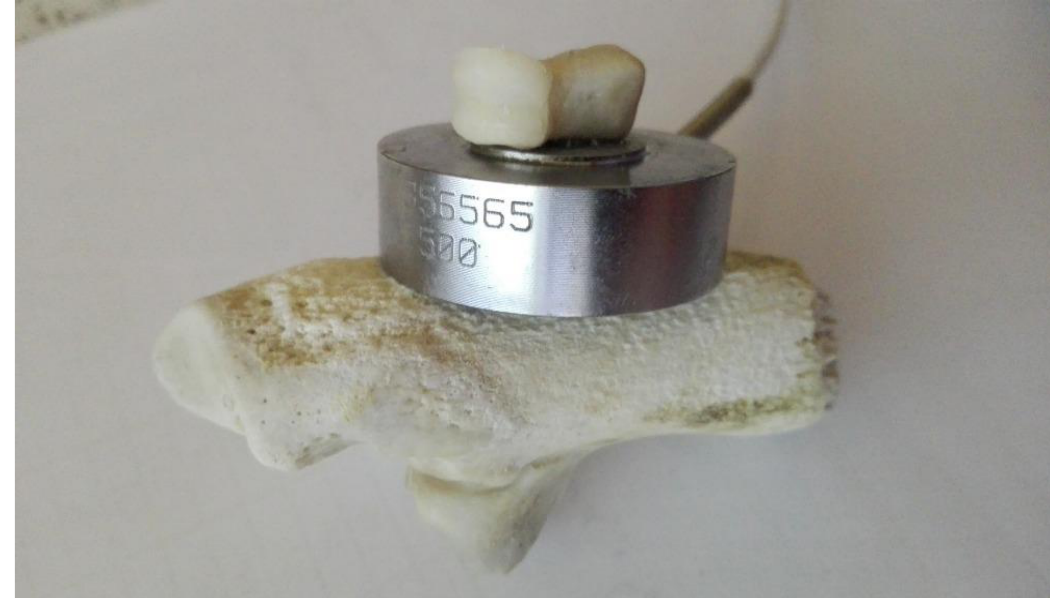
Figure 12. Two bone fragments with a force sensor connected by a headless screw.